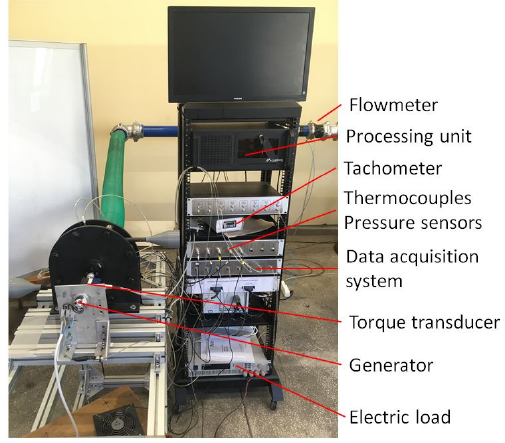
Figure 3. Scheme of air installation.